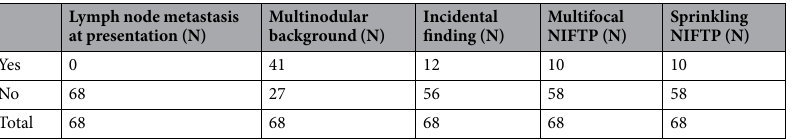
Lymph node metastasis at presentation (N)